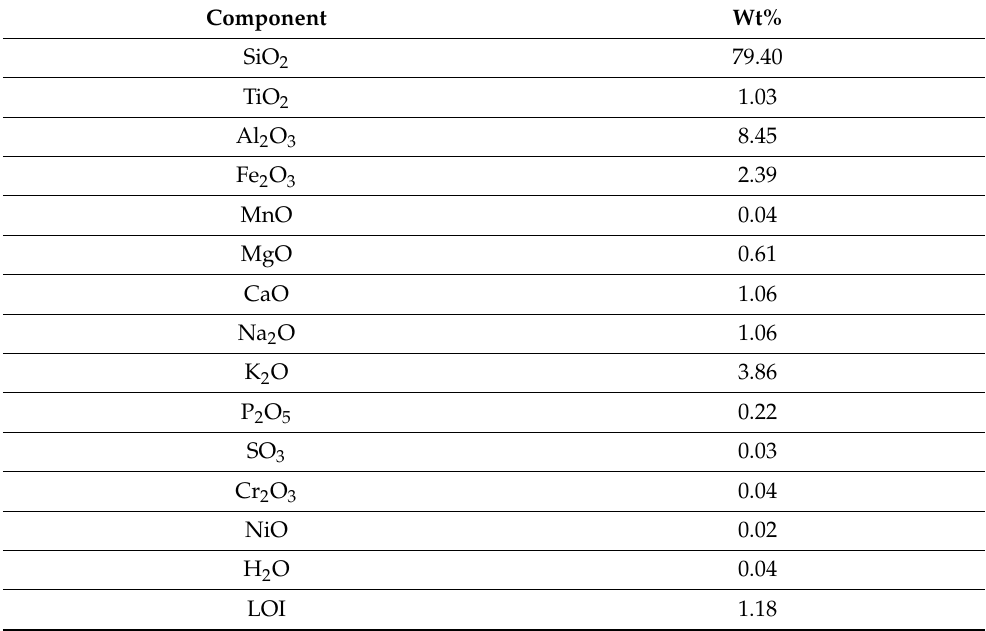
Table 2. Chemical composition of acid-leached SCBA from